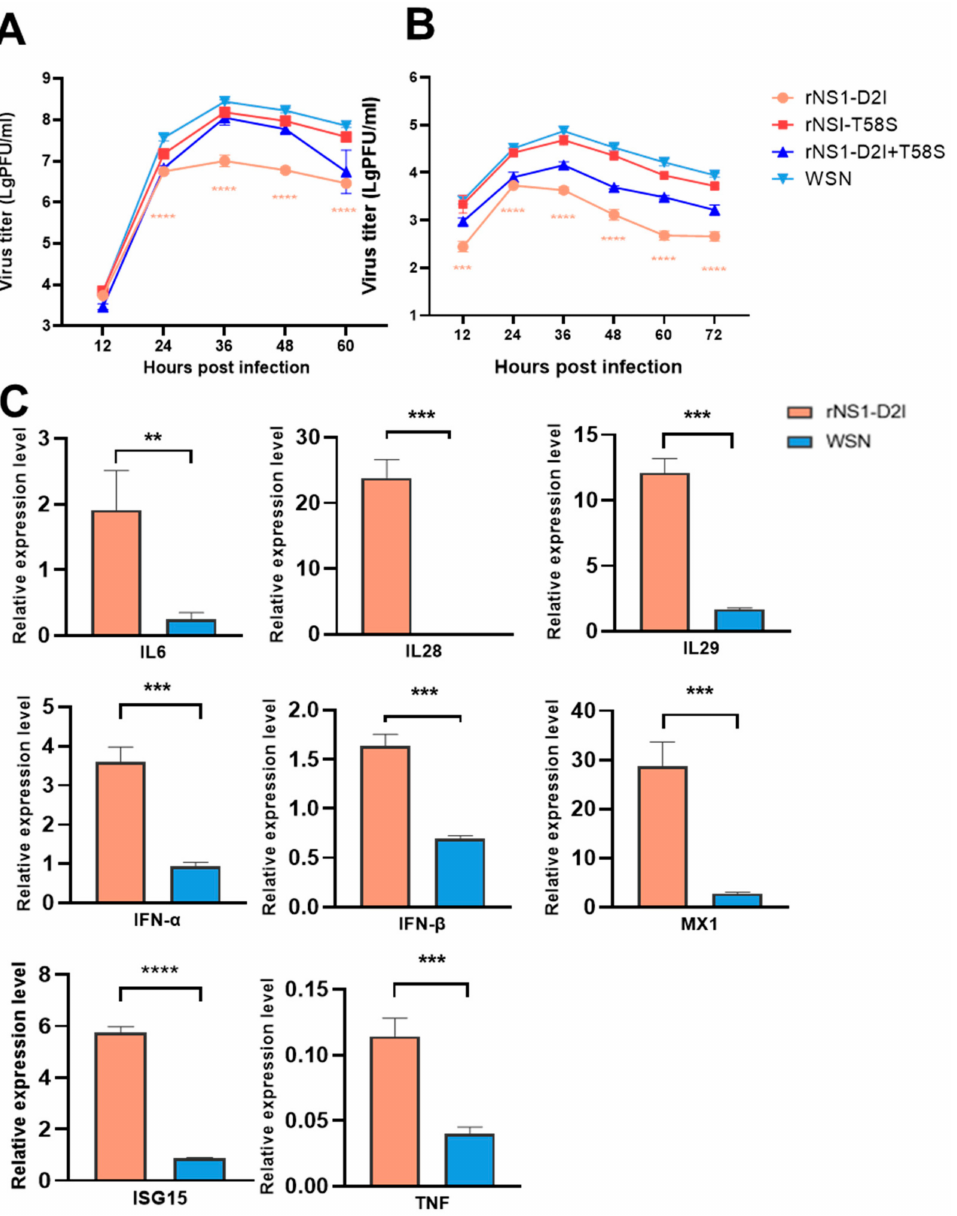
Figure 6. In vitro characterizations of WSN NS1 D2I mutated viruses. ( A ) Growth kinetics of rNS1 D2I mutant in MDCK cells. ( B ) Growth kinetics of rNS1 D2I mutant in A549 cells. ( C ) The mRNA expression levels of IFNs and ISGs in infected A549 cells. p values were calculated by using the Student’s t -test, ** p < 0.01, *** p < 0.001, **** p <